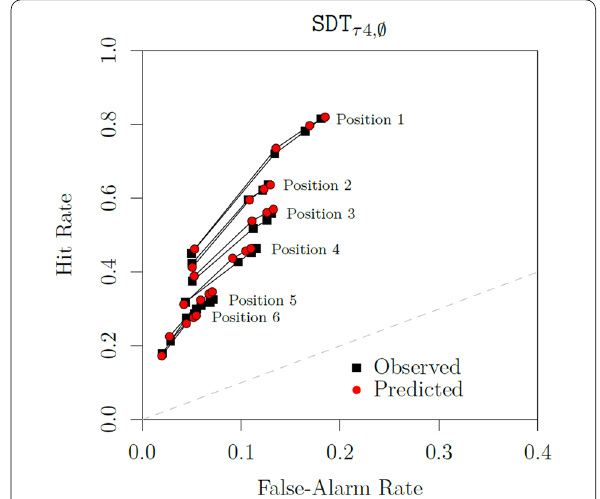
Fig. 9 Observed confidence rating ROCs and the corresponding predictions from SDT τ 4, ∅ (Reanalysis of Wilson et al.,